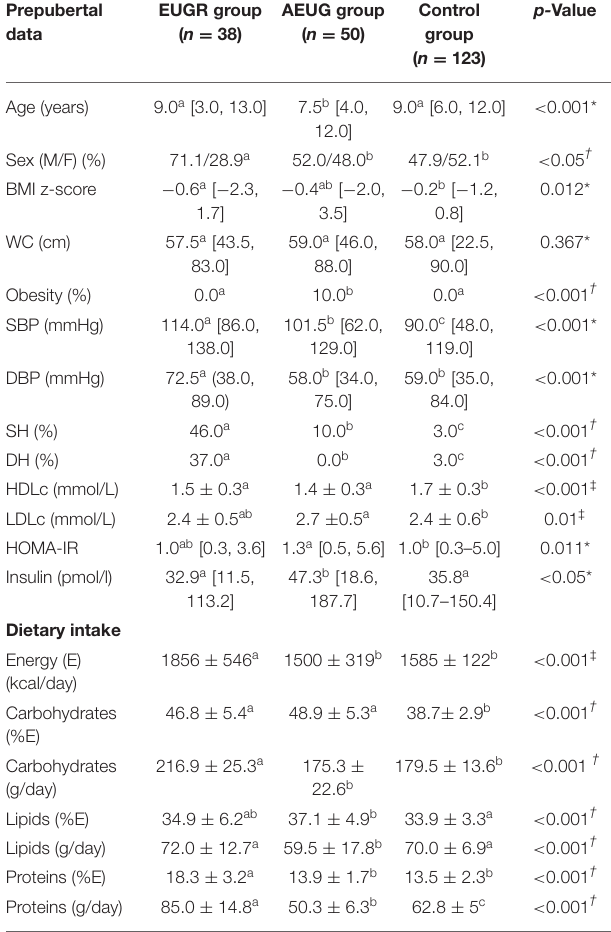
TABLE 2 | General data and energy and macronutrients intake (% of energy) of prepubertal children with a history of prematurity and extrauterine growth restriction (EUGR group), for those with prematurity and adequate extrauterine growth (AEUG group) and for healthy children (control